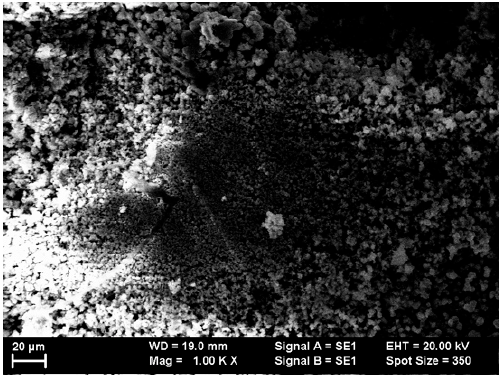
Figure 2. SEM image of Mn 52 Al 46 C 2 as-cast sample.